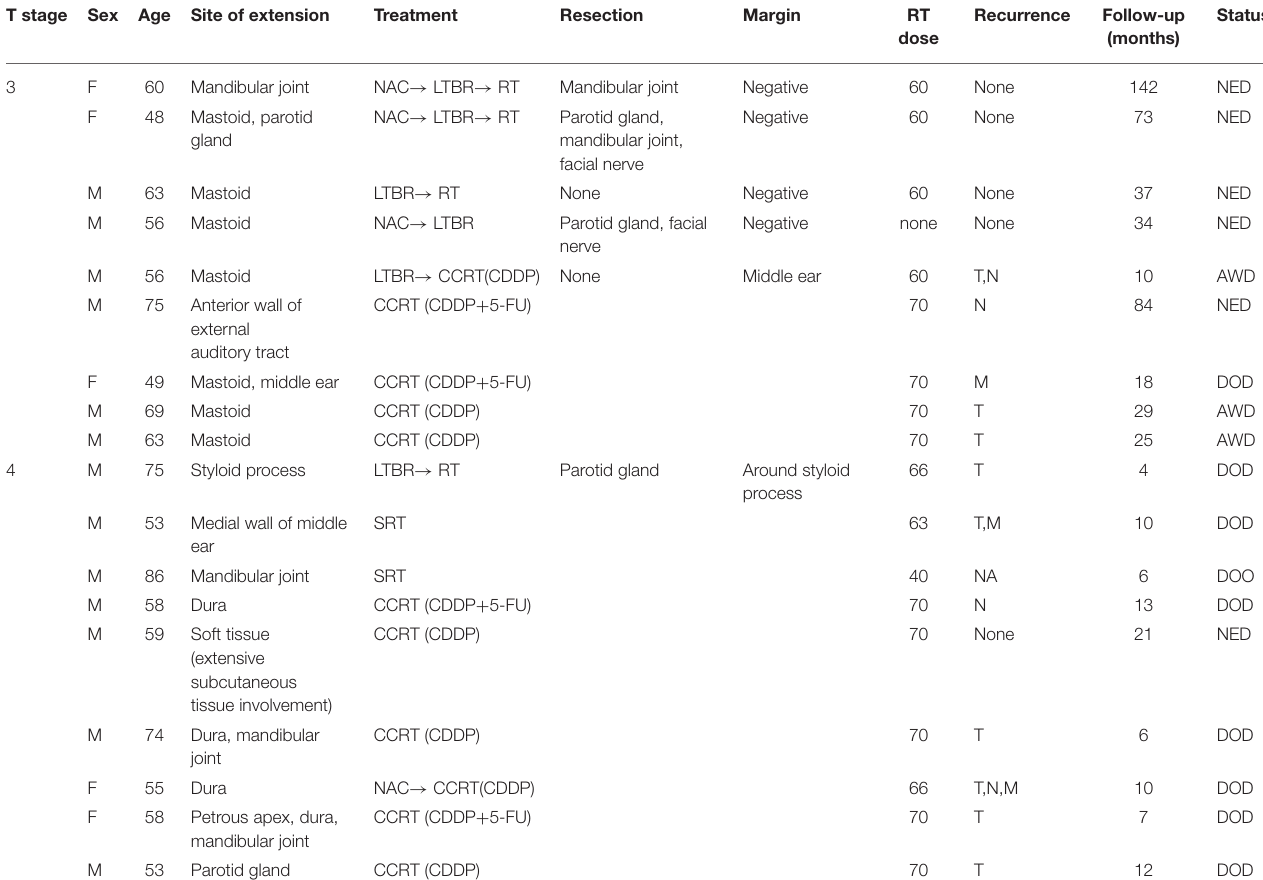
TABLE 2 | Treatment details in T3 and T4